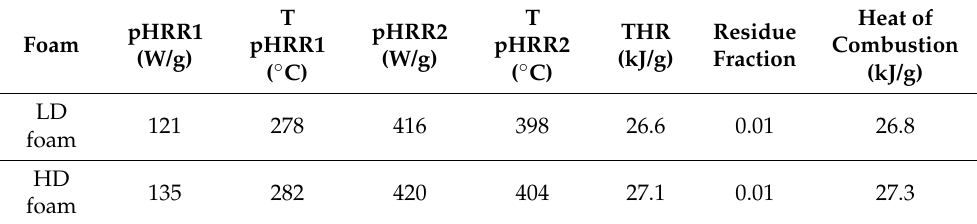
Table 2. Main data from pyrolysis–combustion flow calorimetry on both Table 1. Foam thermal properties.